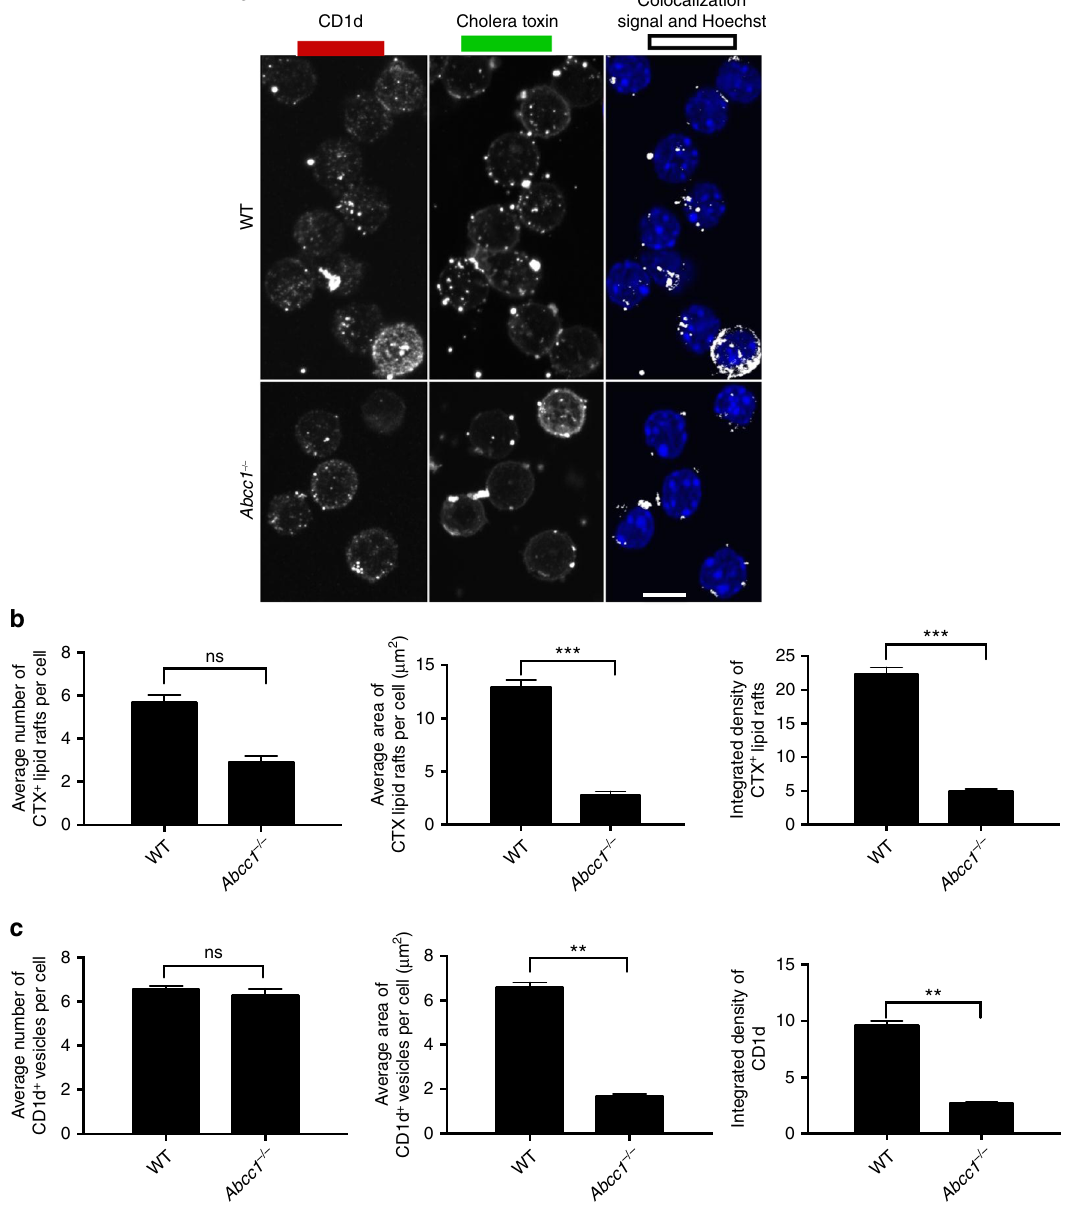
Fig. 10 Alterations in CD1d and lipid rafts in Abcc1 − / − mice. a Peritoneal macrophages from wild-type (WT) and Abcc1 − / − mice were stained with anti- CD1d, Cholera toxin B (CTX) along with Hoechst for staining nucleus. Images were acquired using confocal microscopy. Figure shows representative images for the localization of CD1d in CTX + compartment in peritoneal macrophages at steady state. b Figure represents the number of Cholera toxin (CTX + ) vesicles, average area of CTX + vesicles, and integrated density of CTX expression. c A compilation of the number of CD1d vesicles, average area of CD1d vesicles, and integrated density of CD1d expression on the cell surface. Representative images from one of two experiments with at least 100 cells per condition. Scale bar 10 μ m. Graphs represent mean ± SEM. ** p < 0.01; *** p < 0.001 (one-way ANOVA). See also Supplementary Fig.